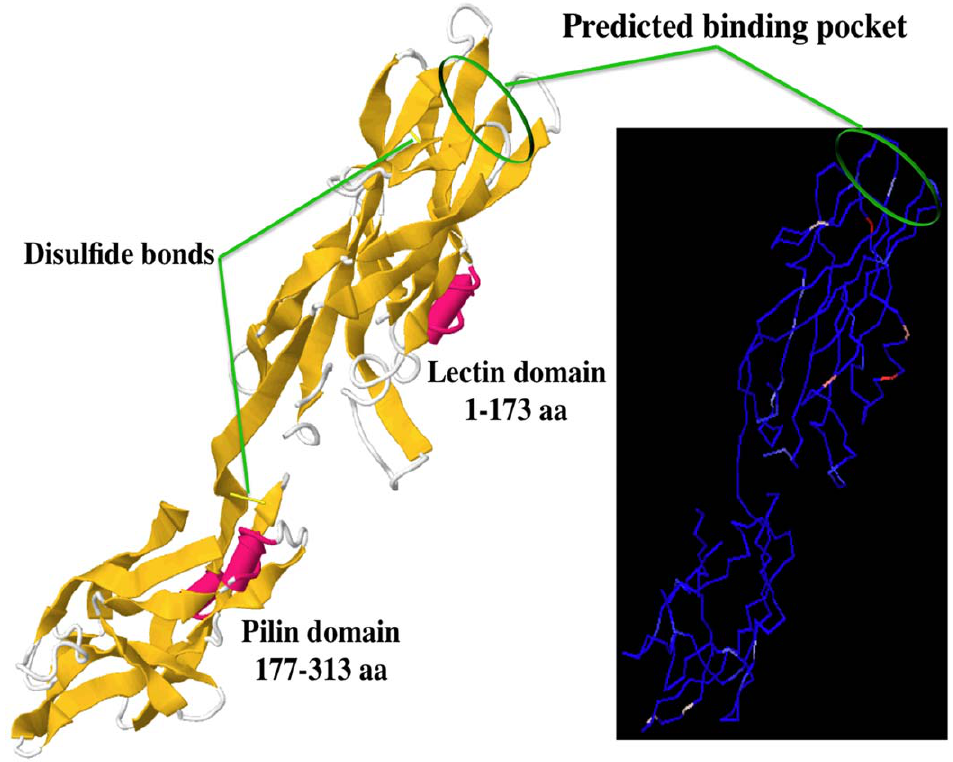
Figure 4. Predicted structural model of the Salmonella FimH fimbrial adhesin. The structure of the Salmonella FimH protein was based on the template structure 1klf (Protein Data Bank) from the E. coli FimH adhesin [119]. On the left, ribbon model of the predicted structure of Salmonella FimH with its lectin and pilin domains, each with one disulfide bond. ˜ b -barrel are shown in yellow and a -helices are shown in pink. On the right, the variable amino acid positions are shown in a tube-rendering model of the FimH backbone structure, with a color gradation from blue (most conserved residues) to red (most variable positions). None of the natural variable positions were located in the predicted binding pocket, shown as green circles on both